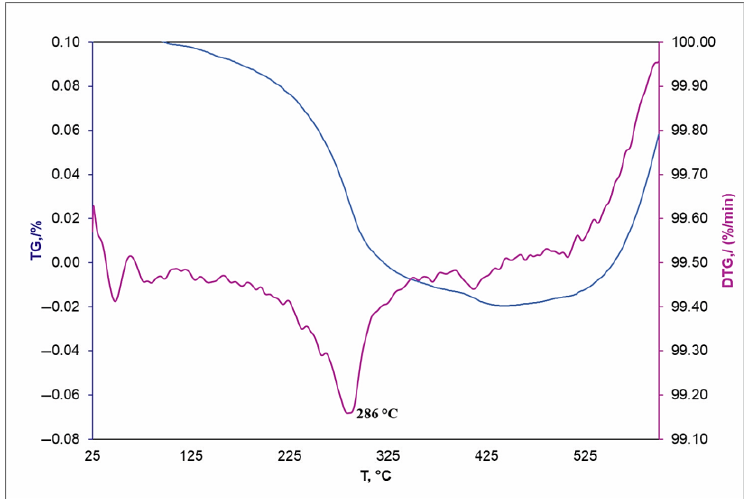
Figure 7. TG and DTG of TiNi modified with BU[6] under vacuum.